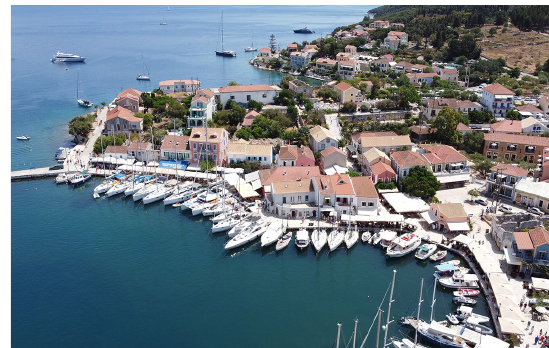
Figure 2 . Fiskardo Port, drone photo, southern